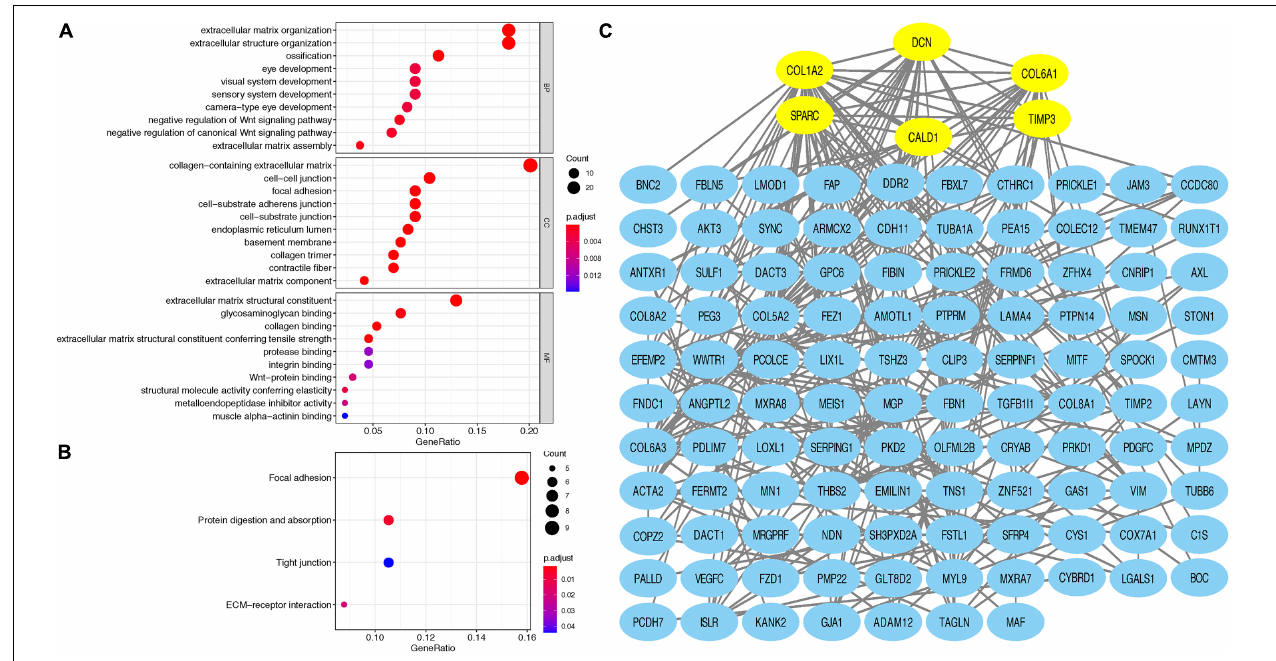
FIGURE 3 | (A) Top 10 GO terms, including BP, CC, and MF, respectively, enriched according to the hub genes in the red module; (B) KEGG terms enriched according to the hub genes in the red module; (C) Cytoscape software was used to establish the PPI network of hub genes in the red module based on the STRING website; yellow signifies the hub nodes. GO, Gene Ontology; BP, biological process; CC, cellular component; MF, molecular function; KEGG, Kyoto Encyclopedia of Genes and Genomes; PPI, protein–protein interaction.